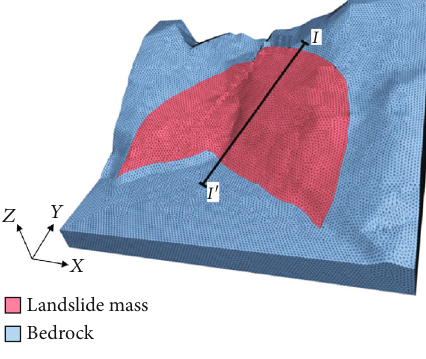
Figure 6: FLAC 3D numerical